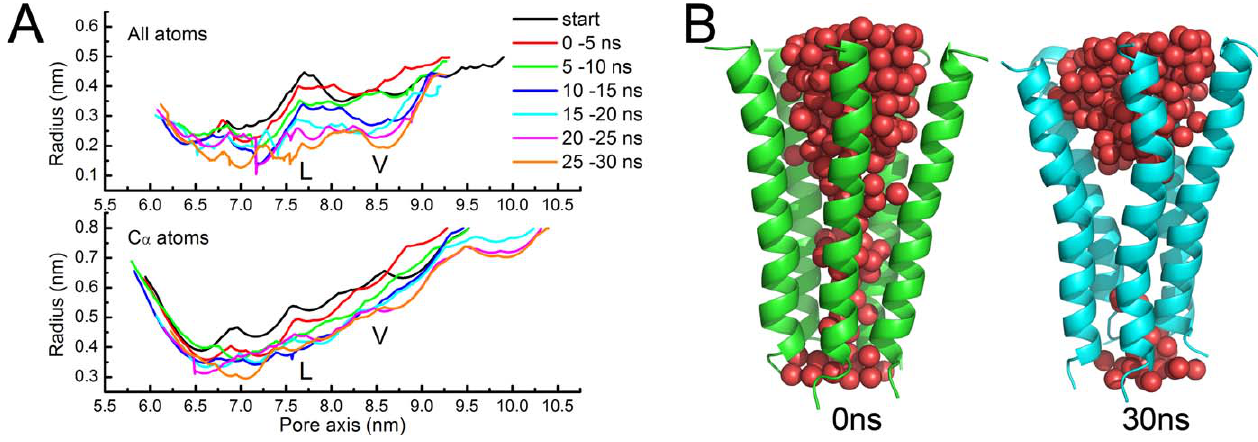
Figure 4. Changes of the Pore Channel (A) Pore radius profiles versus position along the pore axis. Curves represent the average radii changes over different time intervals for the all-atoms (top) and C a atoms (bottom) of the five M2 helices. (B) The volume change of the pore channel reflected by the water molecules embedded within the channel. doi:10.1371/journal.pcbi.0040019.g004 PLoS Computational Biology |